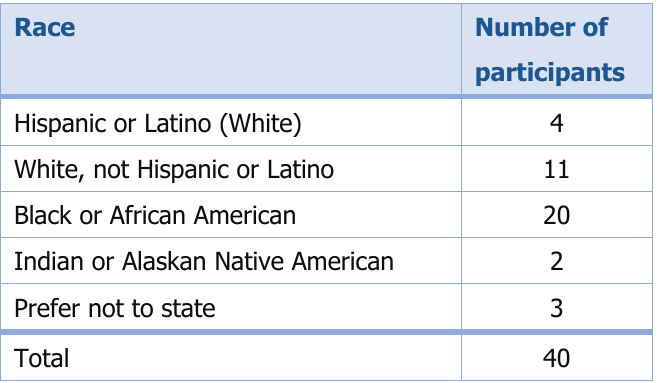
Table 1. Race of Study